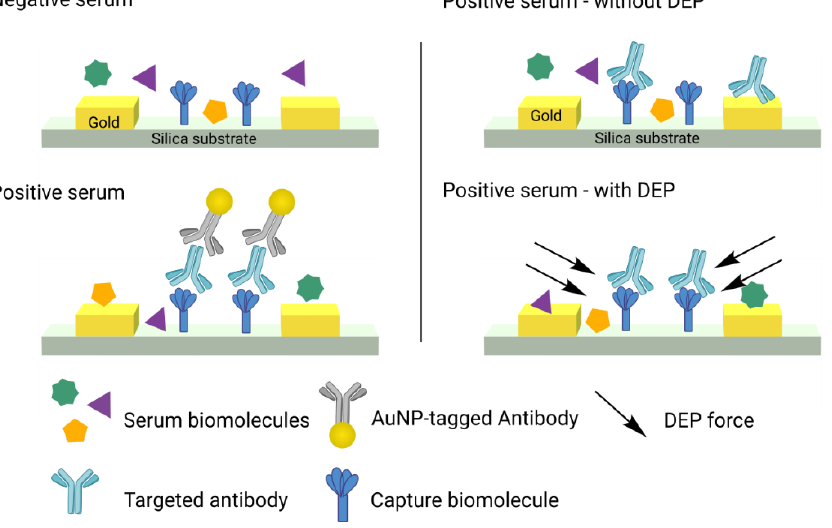
Figure 4. Enhancement of SARS-CoV-2 antibodies detection via the use of AuNPs ( left ) or dielec- trophoresis force ( right ). Adapted from Zeng et al. 2022 [34].